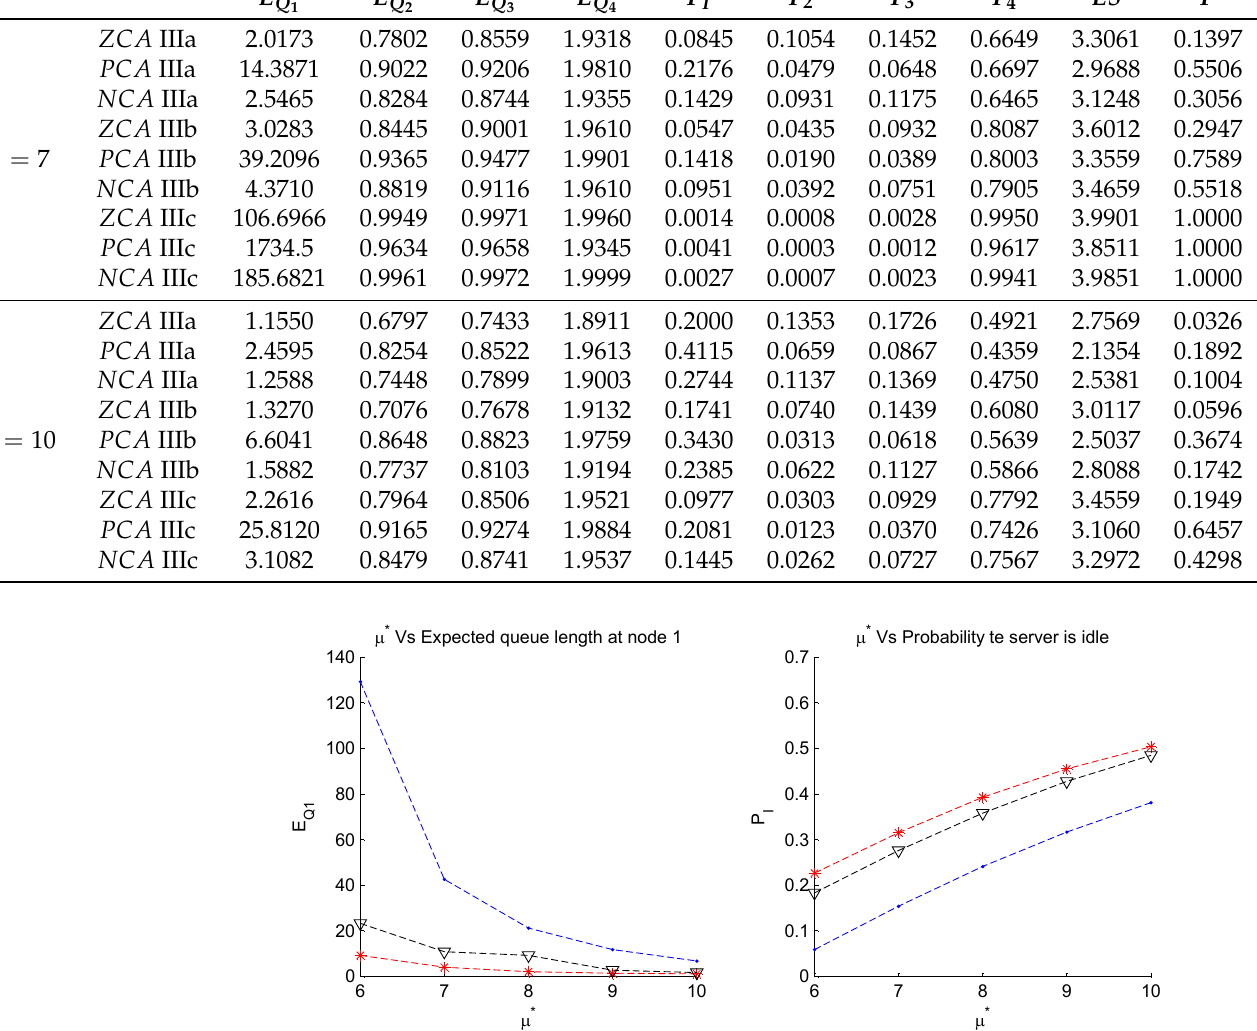
Table 13. Measures for various combination of arrival and service processes—Scenario III.